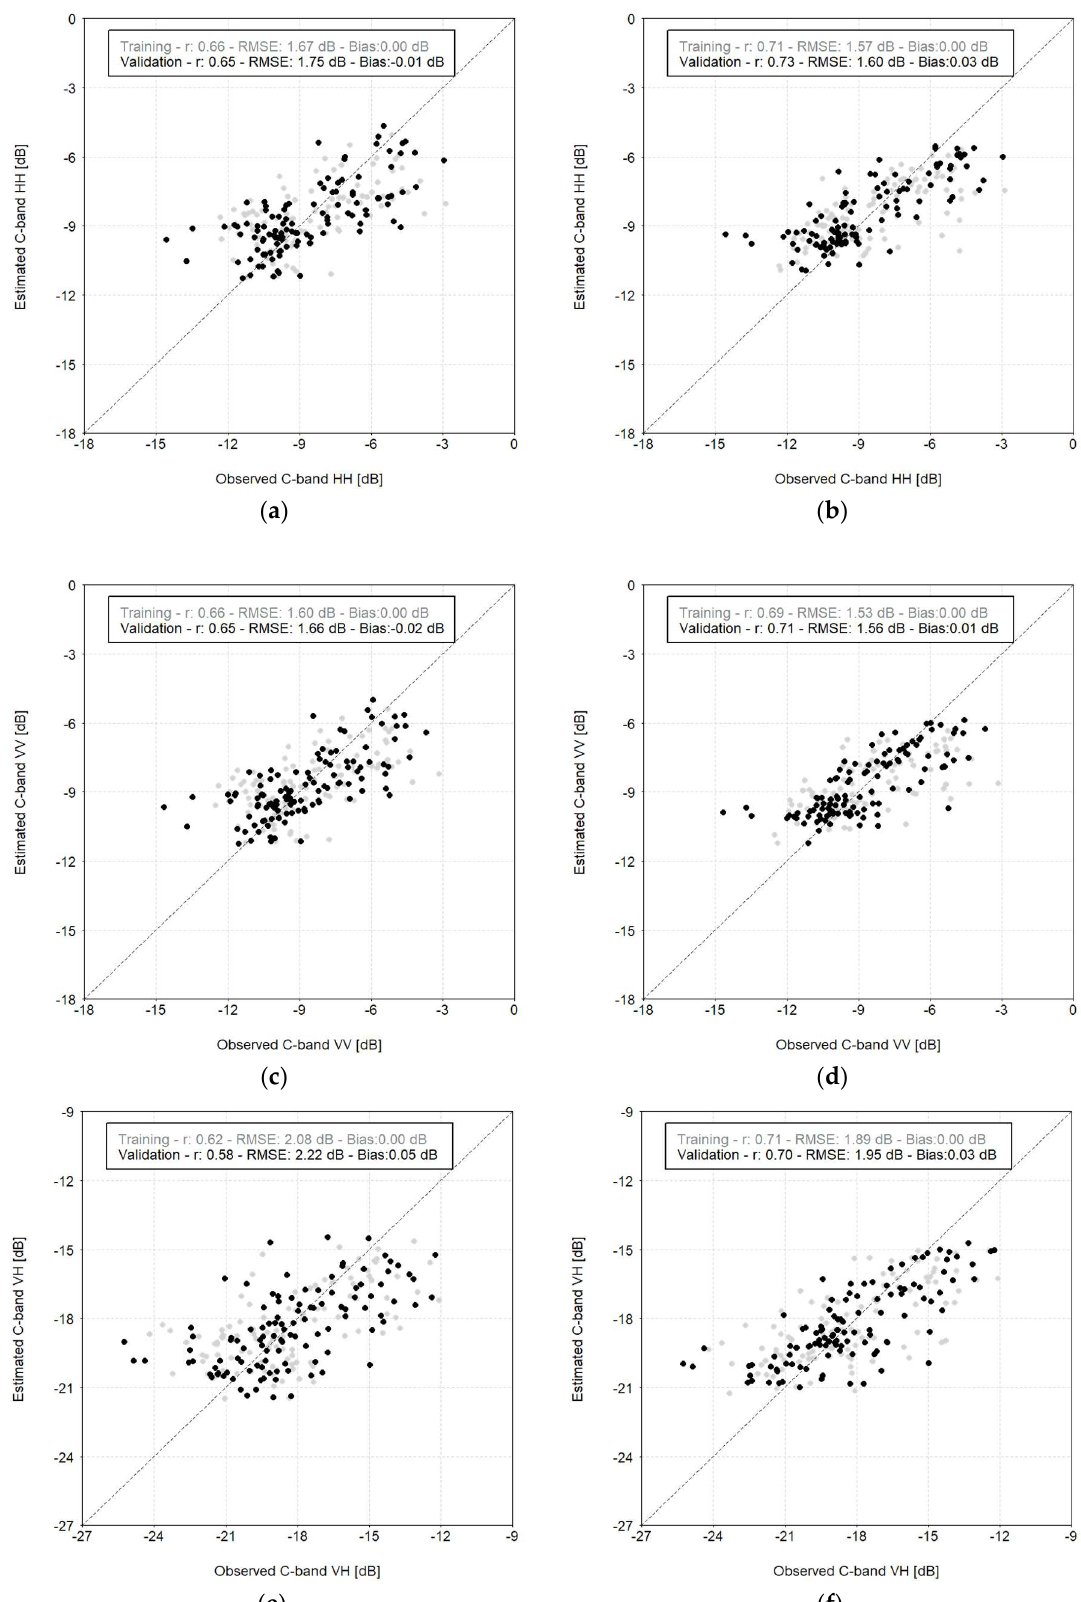
Figure 8. Comparison between simulated and observed backscattering coefficients in the C-band in three polarizations states (HH ( a , b ), VV ( c , d ) and VH ( e , f )) using MLR (left) or RF (right) statistical algorithm. The gray dots represent the estimates obtained on the training subset, while the black dots come from the validation subset.